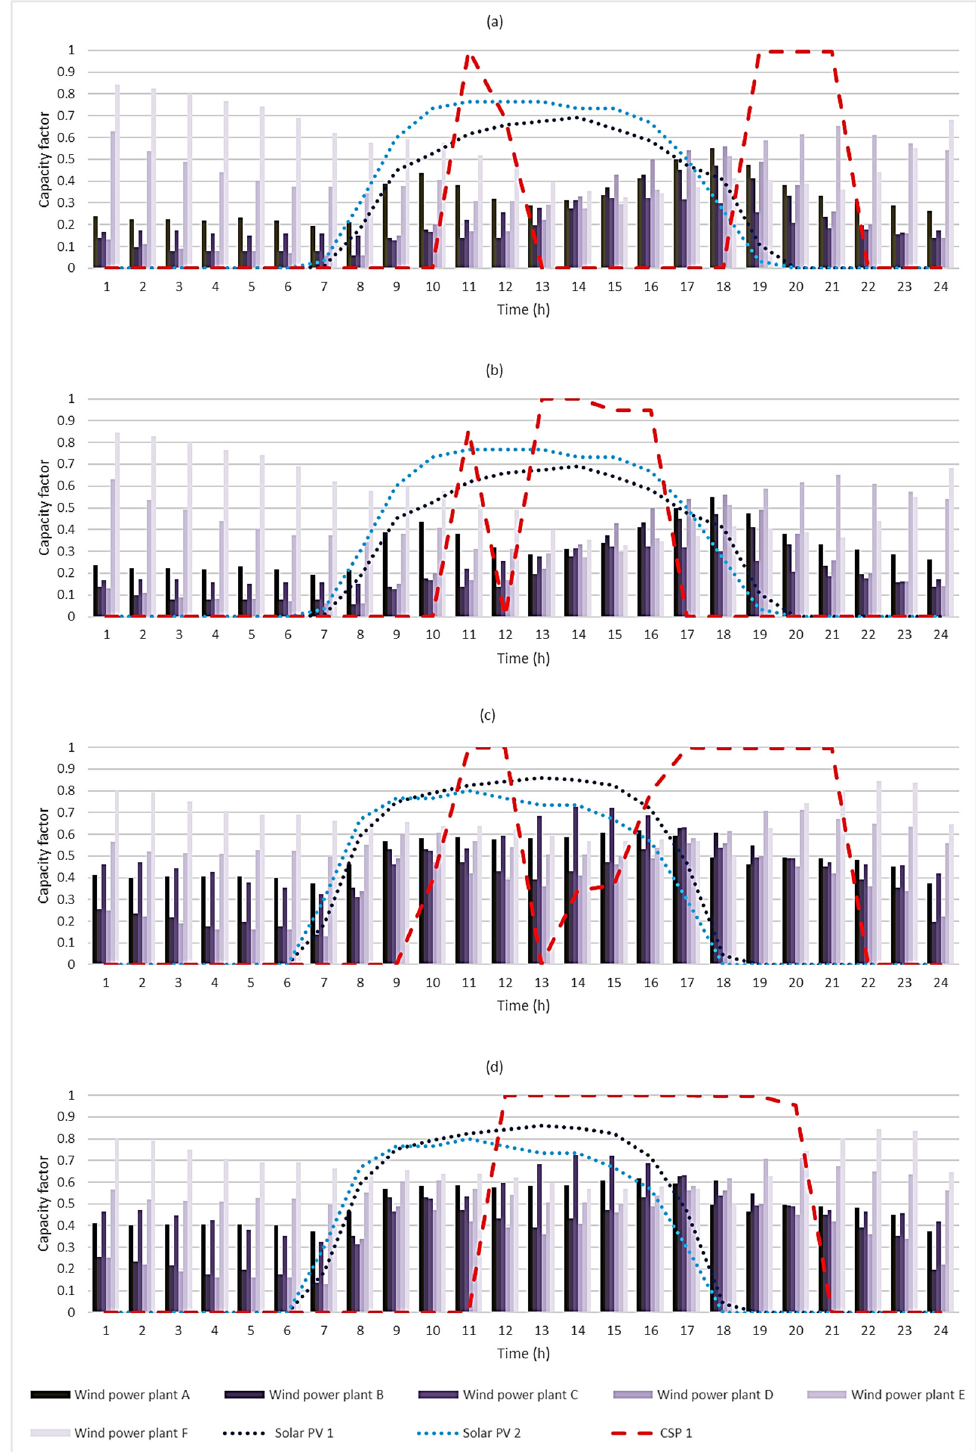
Figure 10. Capacity factor of wind farms, photovoltaic plants, and CSP 1 in the following scenarios: wet/night ( a ), wet/day ( b ), dry/night ( c ), and dry/day ( d ).